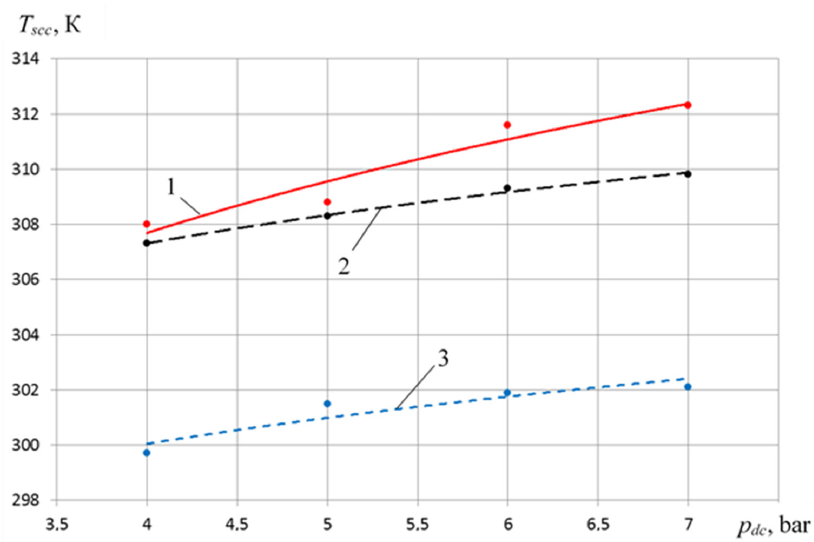
Figure 31. Dependence of the temperature of the valve plate on the discharge pressure of the compressor section (1—PHPM with step-type gap seals; 2—PHPM with smooth gap seals; 3—Crosshead-free PHPM).